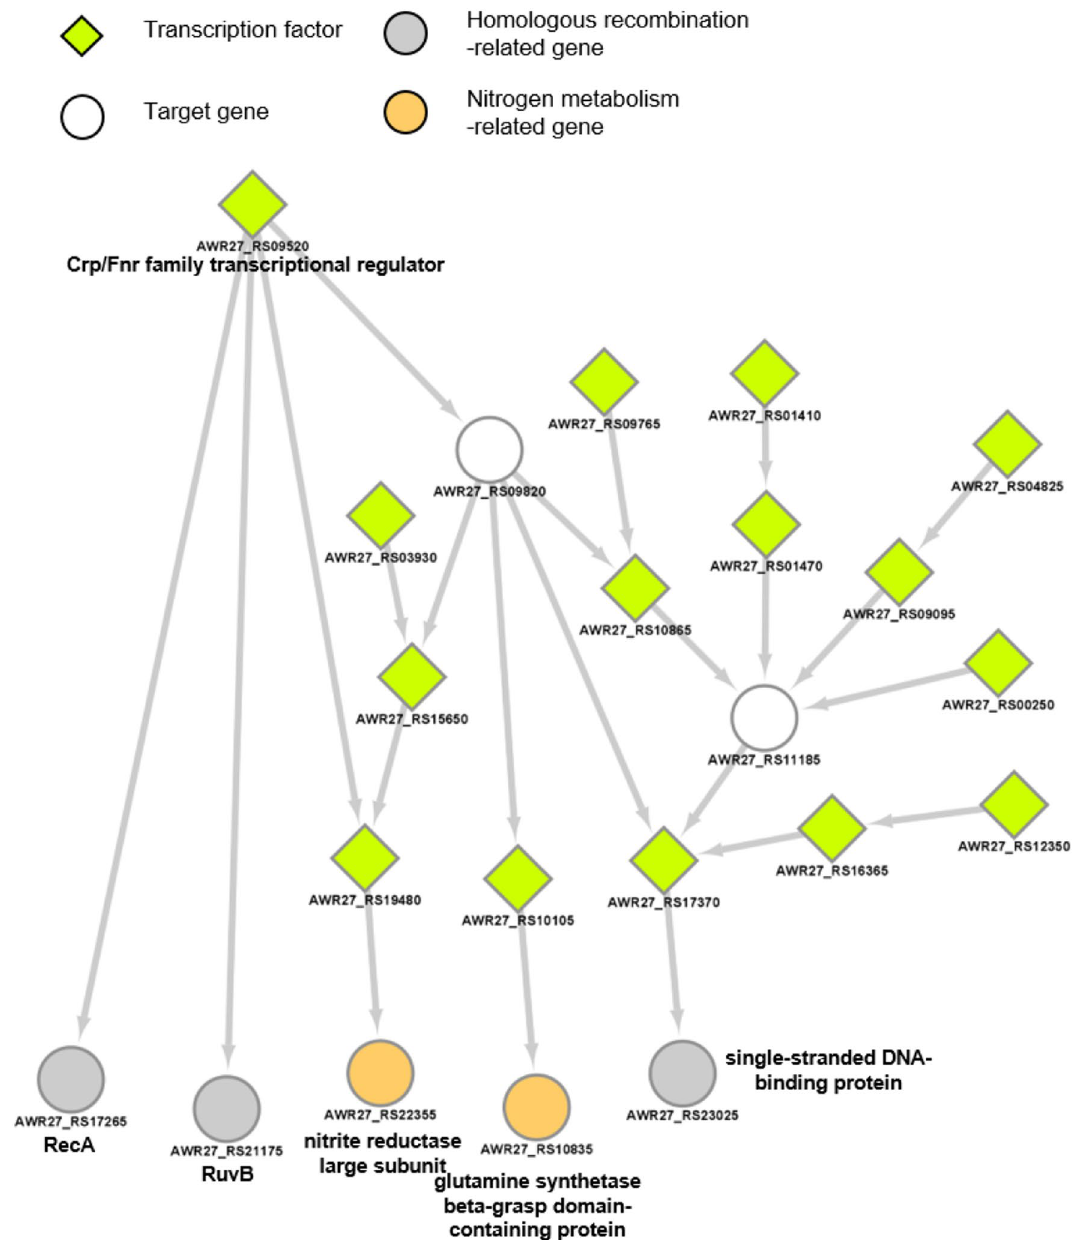
Figure 5. Homologous recombination and Nitrogen metabolism-related transcriptional network module in T early response of Spirosoma montaniterrae DY10 to UVC radiation. Network represents regulatory relation between genes. In the network, diamond shaped nodes are transcription factors and circled nodes are target genes. Grey colored nodes are Homologous recombination-related genes and orange colored genes are Nitrogen metabolism-related